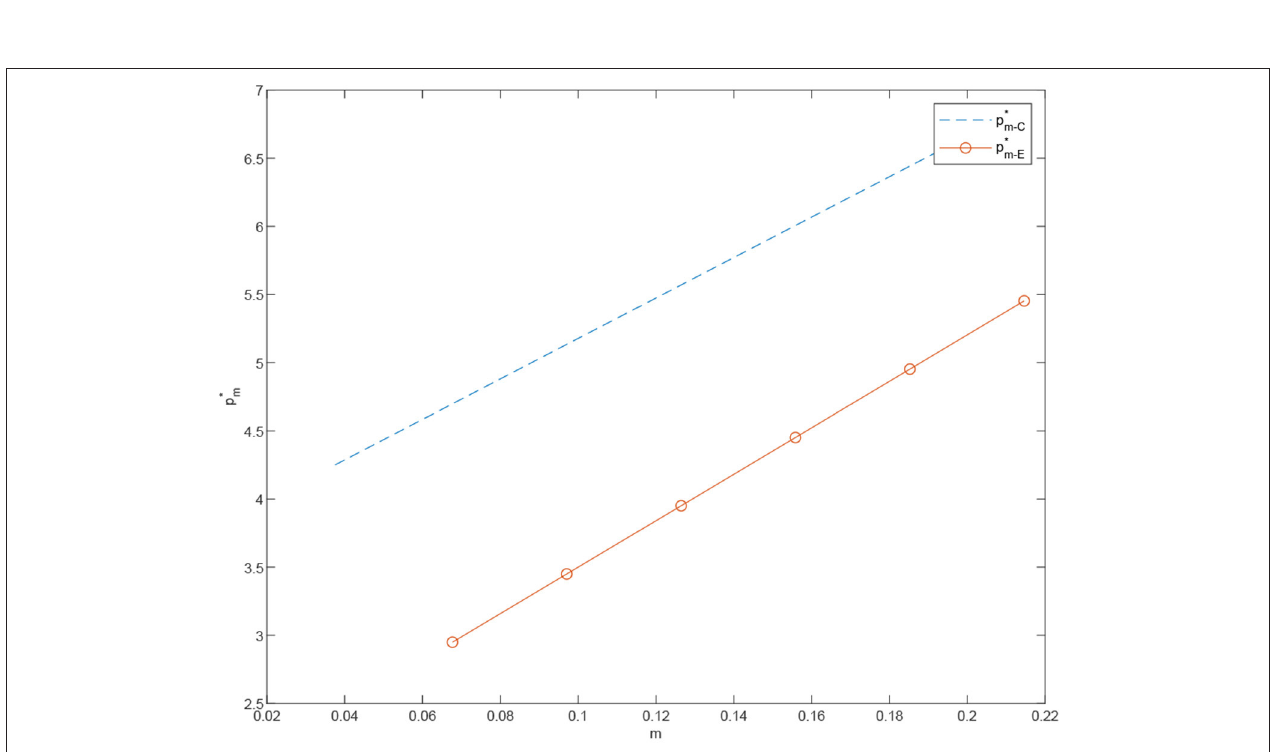
Frontiers in Psychology |